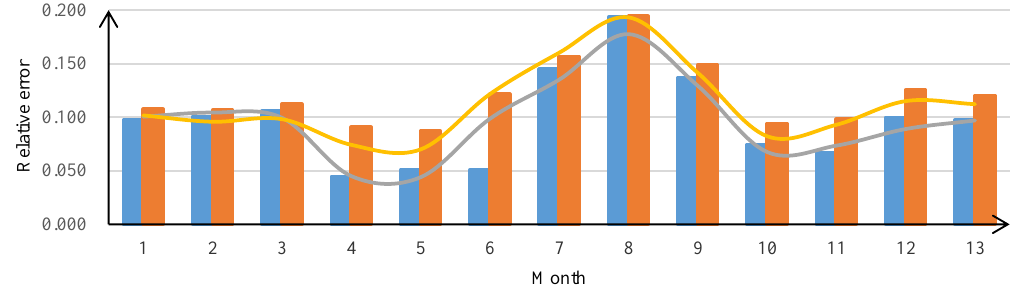
Figure 5. Comparison between the mean relative error of each month under different sample conditions and the relative error under the condition that the month of sample data is the same as the month of referred visibility.